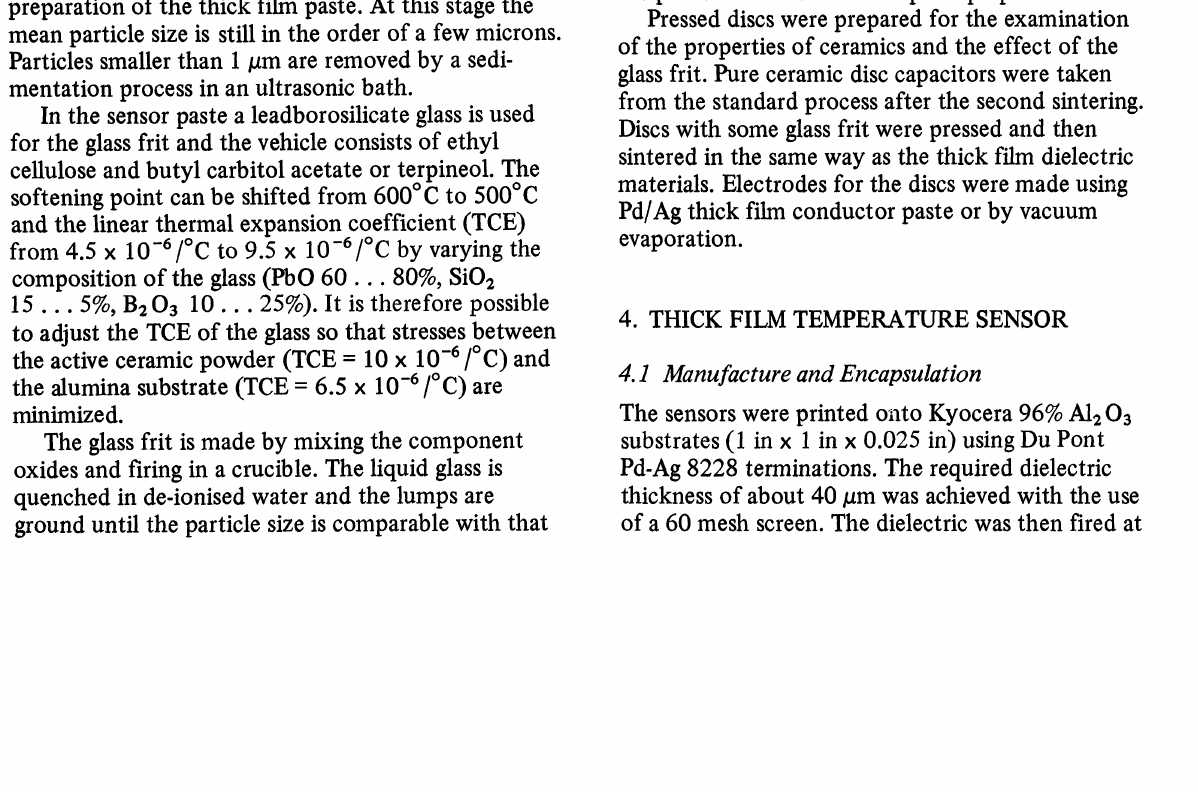
Preparation of the sensor